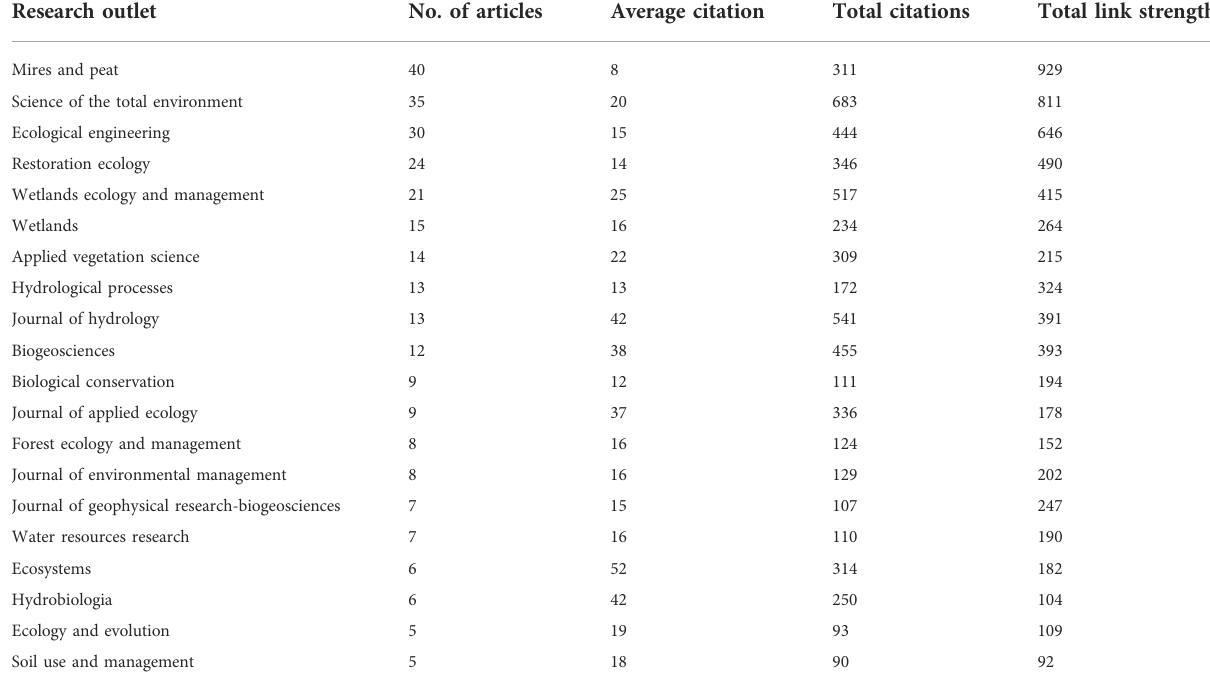
TABLE 3 Research outlets in the restoration of degraded peatland research.